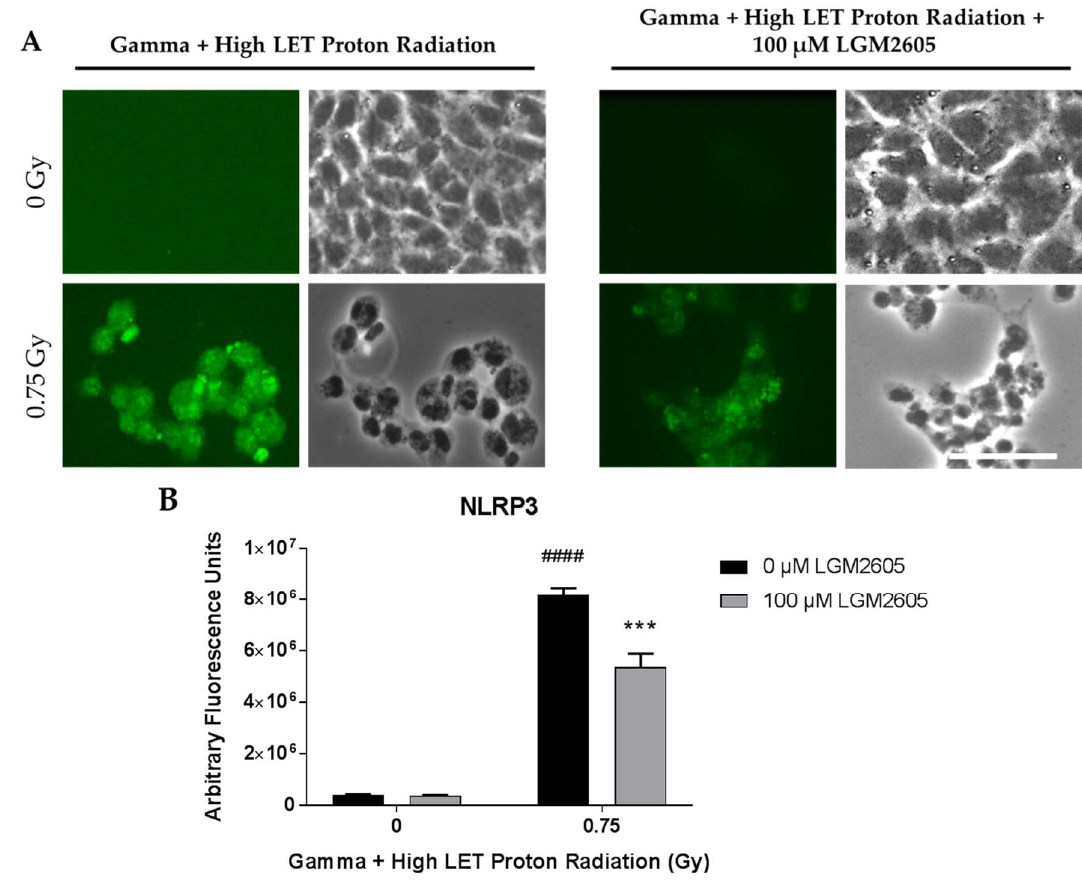
Figure 8. Evaluation of LGM2605 inhibition of NLRP3 activation in in vitro lung vascular networks (flow-adapted endothelial cells) exposed to mixed field gamma and proton radiation. FAECs were exposed to 0 Gy or 0.25 Gy gamma radiation and subsequently exposed to 0 Gy or 0.5 Gy high LET (8–10 keV/ µ m) proton radiation. FAECs were treated with 0 µ M or 100 µ M LGM2605 30 min following gamma radiation exposure. Cells were harvested 24 h post radiation exposure and evaluated for NLRP3 inflammasome activation. Fluorescent images of FAECs exposed to LGM2605 (0 µ M or 100 µ M) 30 min following radiation exposure and harvested at 24 h radiation exposure and incubated with anti-NLRP3 antibody (R&D Systems, Minneapolis, MN, USA). Scale bar = 20 µ m ( A ); graphed representation of the data imaged for each condition ( B ). Data are presented as mean ± SEM. # shown in figures indicate significant differences from FAECs exposed to 0 Gy mixed field gamma and proton radiation and treated with 0 µ M LGM2605 (#### p < 0.0001). Asterisks shown in figures indicate significant differences from FAECs exposed to 0.75 Gy mixed field gamma and proton radiation and treated with 0 µ M LGM2605 (*** p < 0.001).